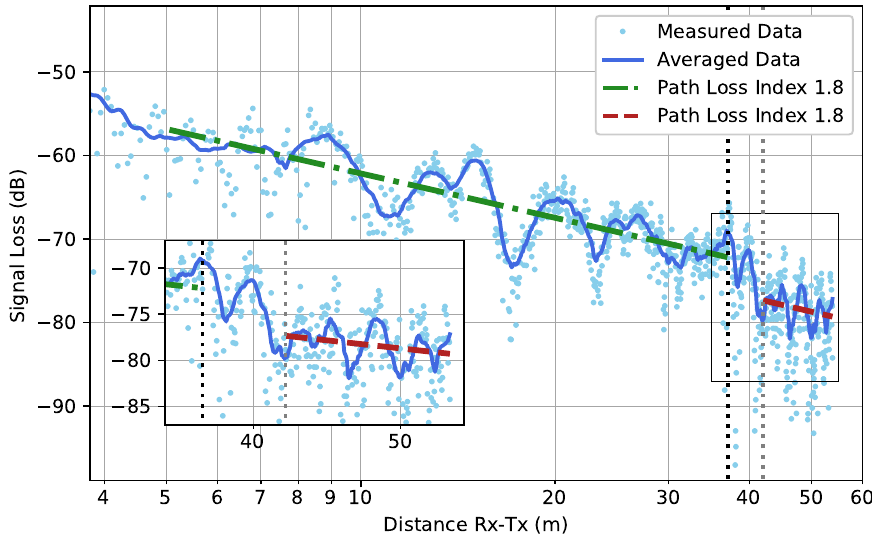
Figure 11. Scenario WIC: The high-resolution measured data together with their averaged values ( solid line ) according to Equation (3). The black dotted line illustrates the position of the corner within the path. The dotted grey line is the point at which the far-zone behavior resumed. Firstly, the path loss was fitted ( dash-dotted line ) on the data until the corner was reached and, secondly, the path loss was fitted ( dashed line ) when the far-zone behavior resumed.